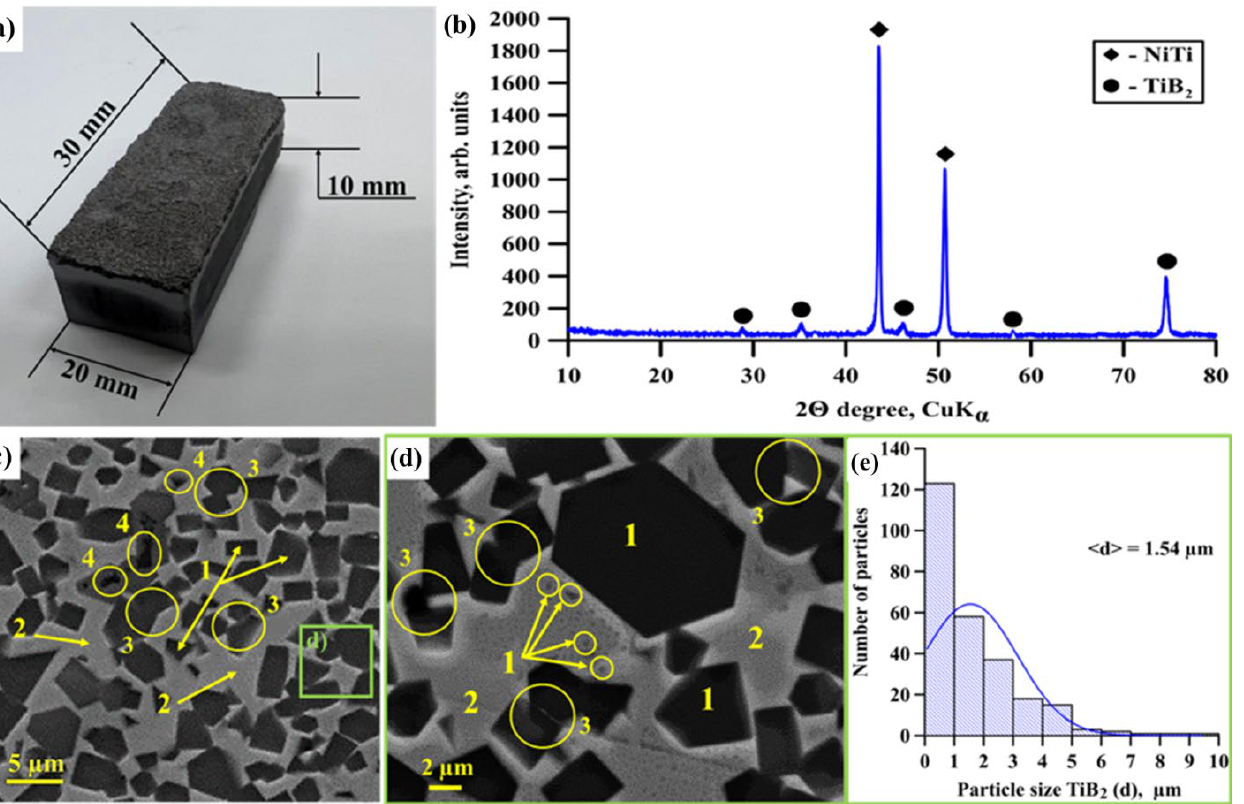
Figure 3. Appearance of sintered NiTi-TiB 2 composite material ( a ), X-ray diffraction pattern of samples obtained by electroerosion treatment from sintered NiTi-TiB 2 materials ( b ), SEM images of structure taken from their polished surface: × 1780 ( c ), × 4020 ( d ), TiB 2 particles (area 1), NiTi intermetallic matrix (area 2), weakly sintered TiB 2 particles (area 3), pores (area 4), a histogram of the distribution of titanium diboride particles inside the intermetallic NiTi matrix ( e ). Table 1. Results of the X - ray diffraction analysis of NiTi -TiB 2 composites fabricated by high -tem- perature vacuum sintering.